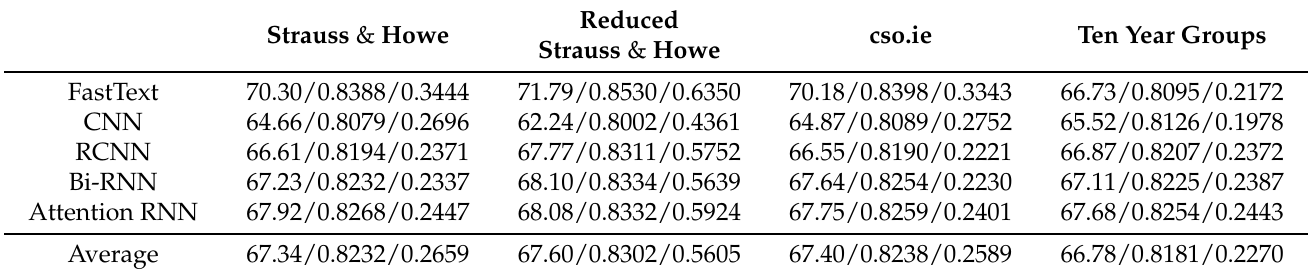
Table 2. Accuracy (%)/MRR/macro-F1-score achieved by the for the different age cohort distributions (test set). Reduced Strauss &